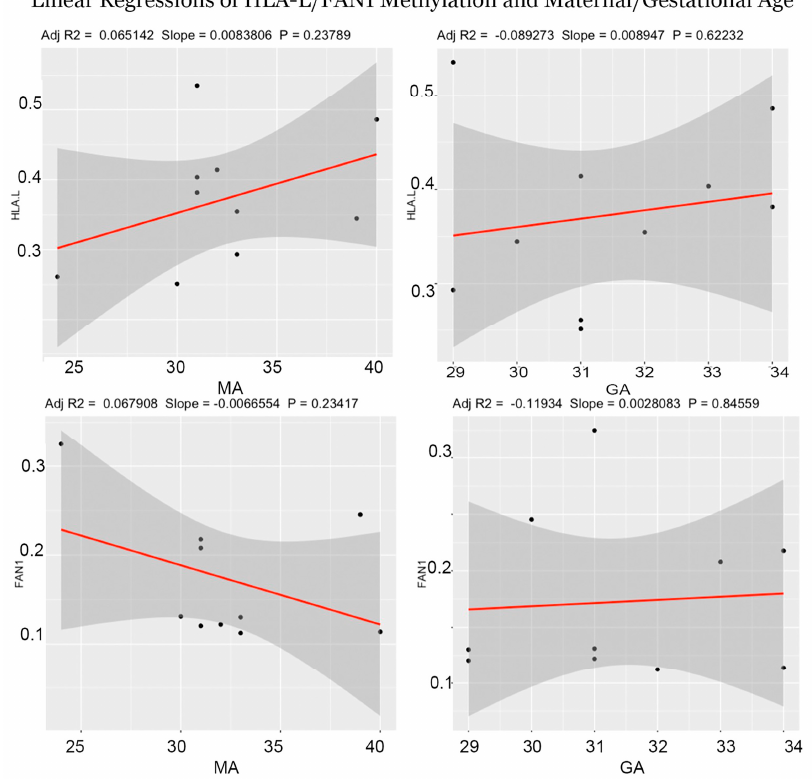
Figure 4. Linear regressions comparing FAN1/HLA-L gene promoter hypomethylation to maternal age (MA)/gestational age (GA). Plot legends include adjusted R 2 values, slopes, and p -values.